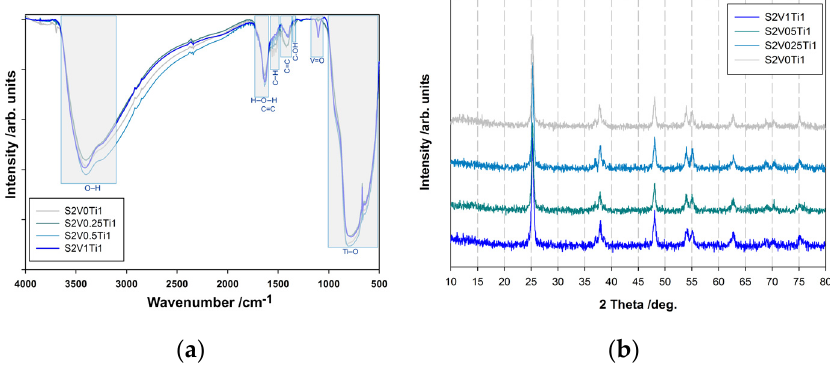
Figure 3. ( a ) FTIR spectra of the obtained materials; ( b ). XRD patterns of the prepared